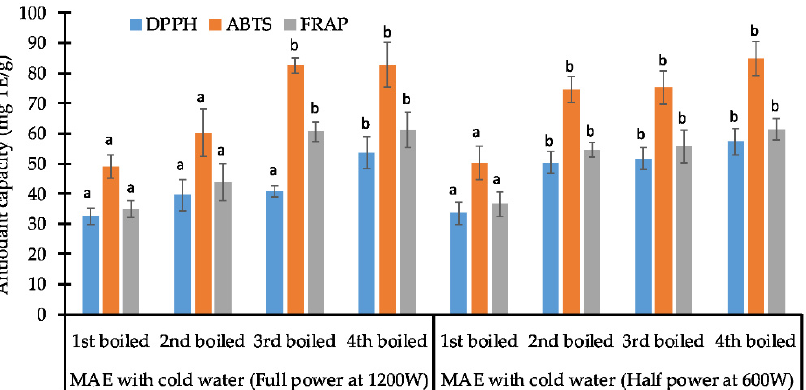
Figure 7. Antioxidant activity of herbal tea infusion prepared at different microwave assisted conditions with cold water. Data are means ± standards deviations. Data for each antioxidant assay (DPPH, ABTS, or FRAP) not sharing similar letters are significantly different at p < 0.05.